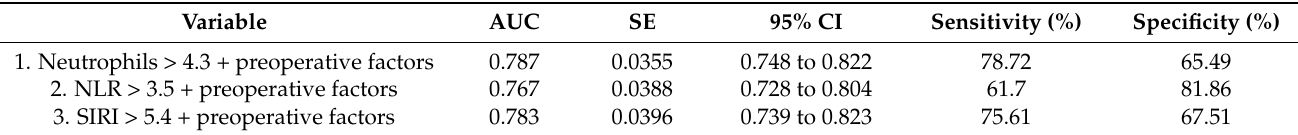
Table 5. Results of different compositions of multifactorial models affecting long-term survival.